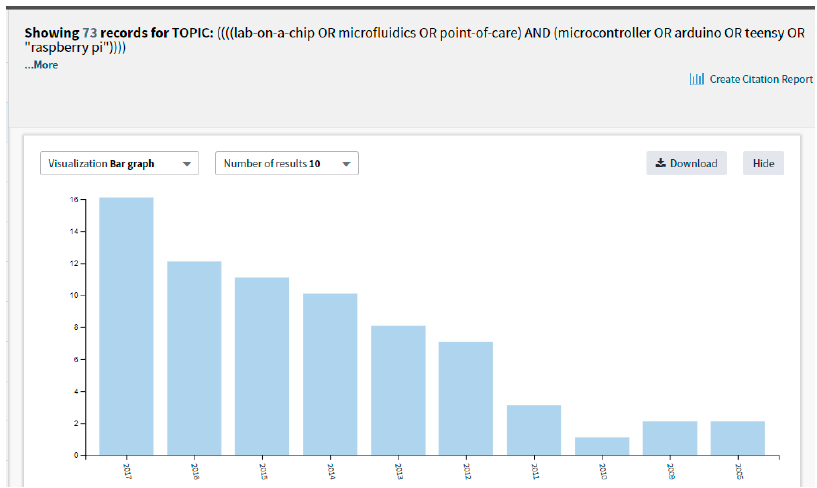
Figure 2. Search result with keyword: “((lab-on-a-chip OR microfluidics OR point-of-care) AND (microcontroller OR arduino OR teensy OR “raspberry pi”))” using Web of Science on 4 August 2018.